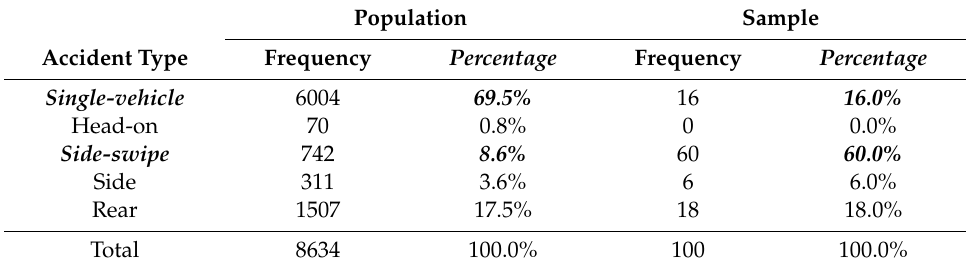
Table 5. Comparison of accident types between population and the studied sample.